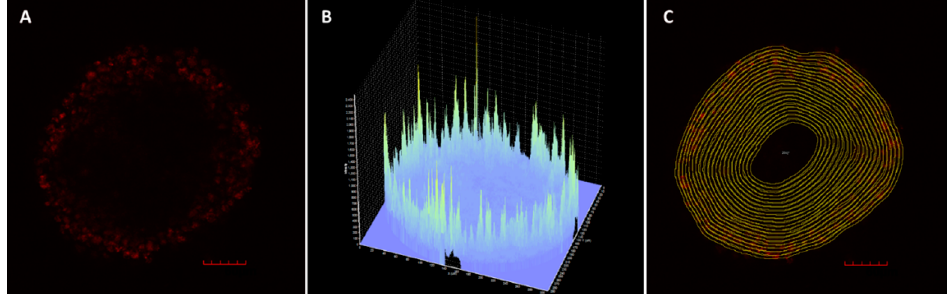
Figure 1. ( A ) Z stack image of a spheroid from U87-MG cells obtained by laser scanning confocal microscopy after 24 h incubation with S1-Dy . ( B ) The uneven 3D fluorescence intensity profile of S1-Dy within the U87-MG spheroid. ( C ) An illustration of the image analysis of a cross-section of the U87-MG spheroid obtained after 24 h incubation with S1-Dy . Z stack image through the middle of the spheroid was divided into identical layers with a width of around 9 µm. The fluorescence intensity was specified in every marked area and the maximum fluorescence intensity was determined to be 100%. This method of image analysis was used to analyze all data. The program ImageJ was used for the analysis of images. Scale bar 100 µm.